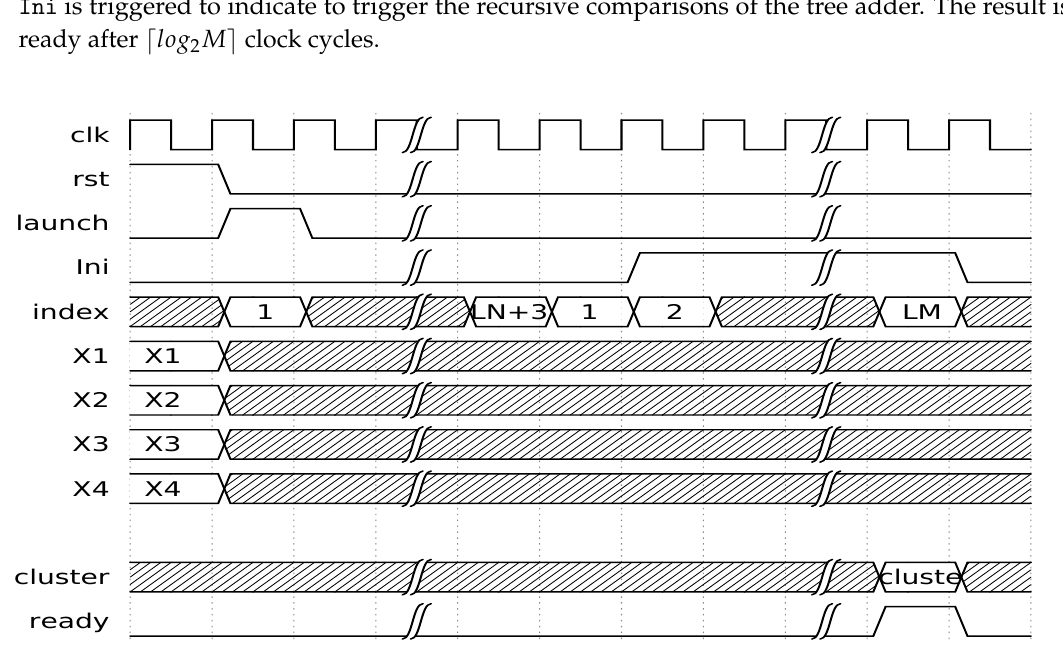
Figure 16. Chronogram of the control-signal sequence of the SOM HW accelerator. LN stands for (cid:100) log (cid:101) , and LM for (cid:100) log (cid:101) 2 N 2 M